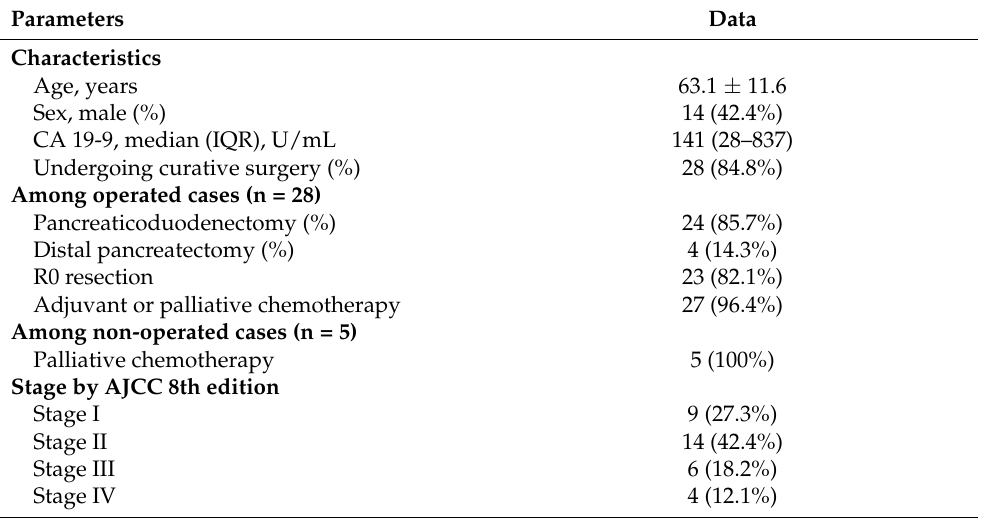
Figure 1. Flowchart of the enrolled patients. Table 1. Patient and tumor characteristics (N =